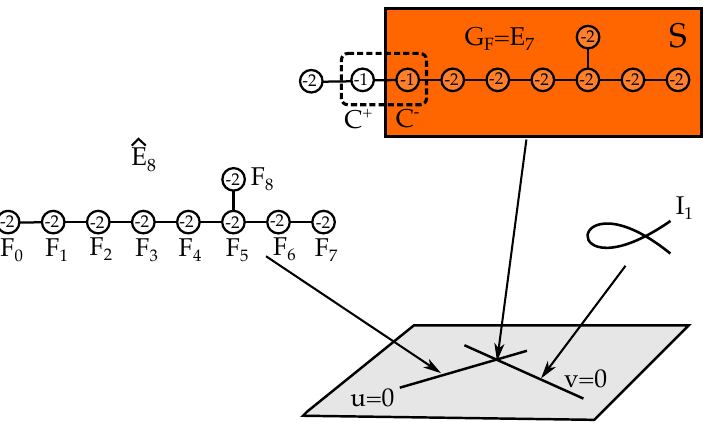
Figure 3 . Rank one E-string: depicted is the collision of two codimension one singularities of type E 8 and I 1 , respectively, as well as the codimension two (cid:12)ber including the non-(cid:13)at component S . In codimension one, the (cid:12)ber above u = 0 is a collection of ( (cid:0) 2)-curves F i (cid:24) = P 1 that are in one-to-one correspondence with the a(cid:14)ne roots of E 8 . At the collision point u = v = 0, one of these rational curves splits (here F 1 ! C + + C (cid:0) ). The non-(cid:13)at (cid:12)ber component S is a complex surface above the codimension two locus, which contains some of the ( (cid:0) 2)-curves of the codimension one (cid:12)ber |